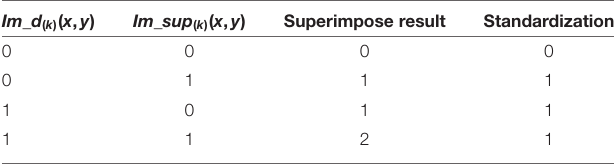
TABLE 3 | The corresponding relationship of the superimpose